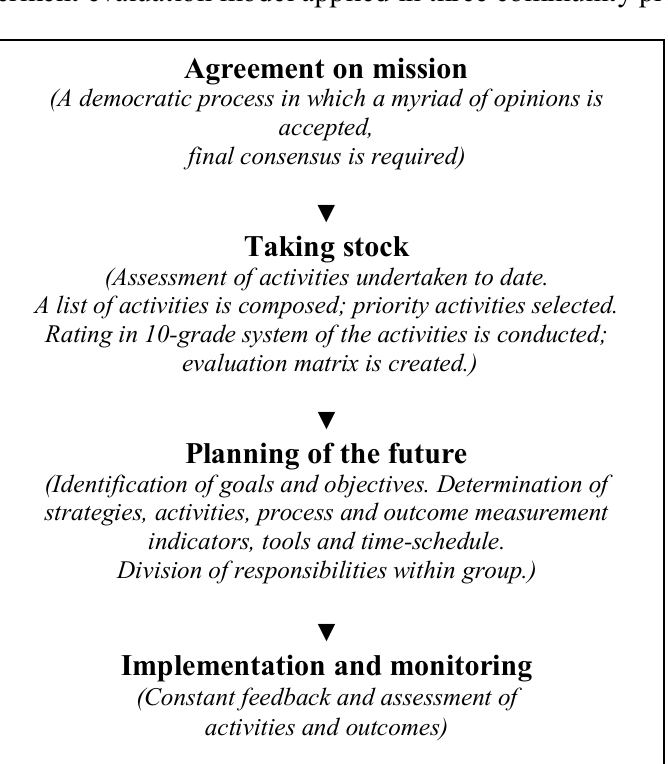
Figure 1. The empowerment evaluation model applied in three community programs’